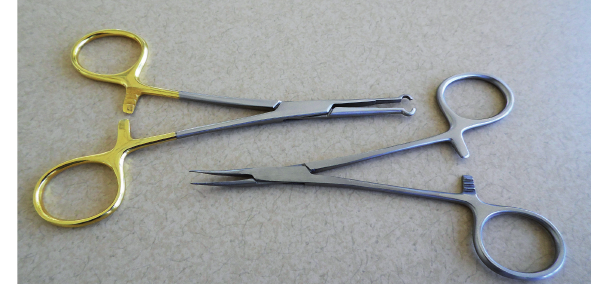
Figure 2 - Vas ring clamp and pointed vas